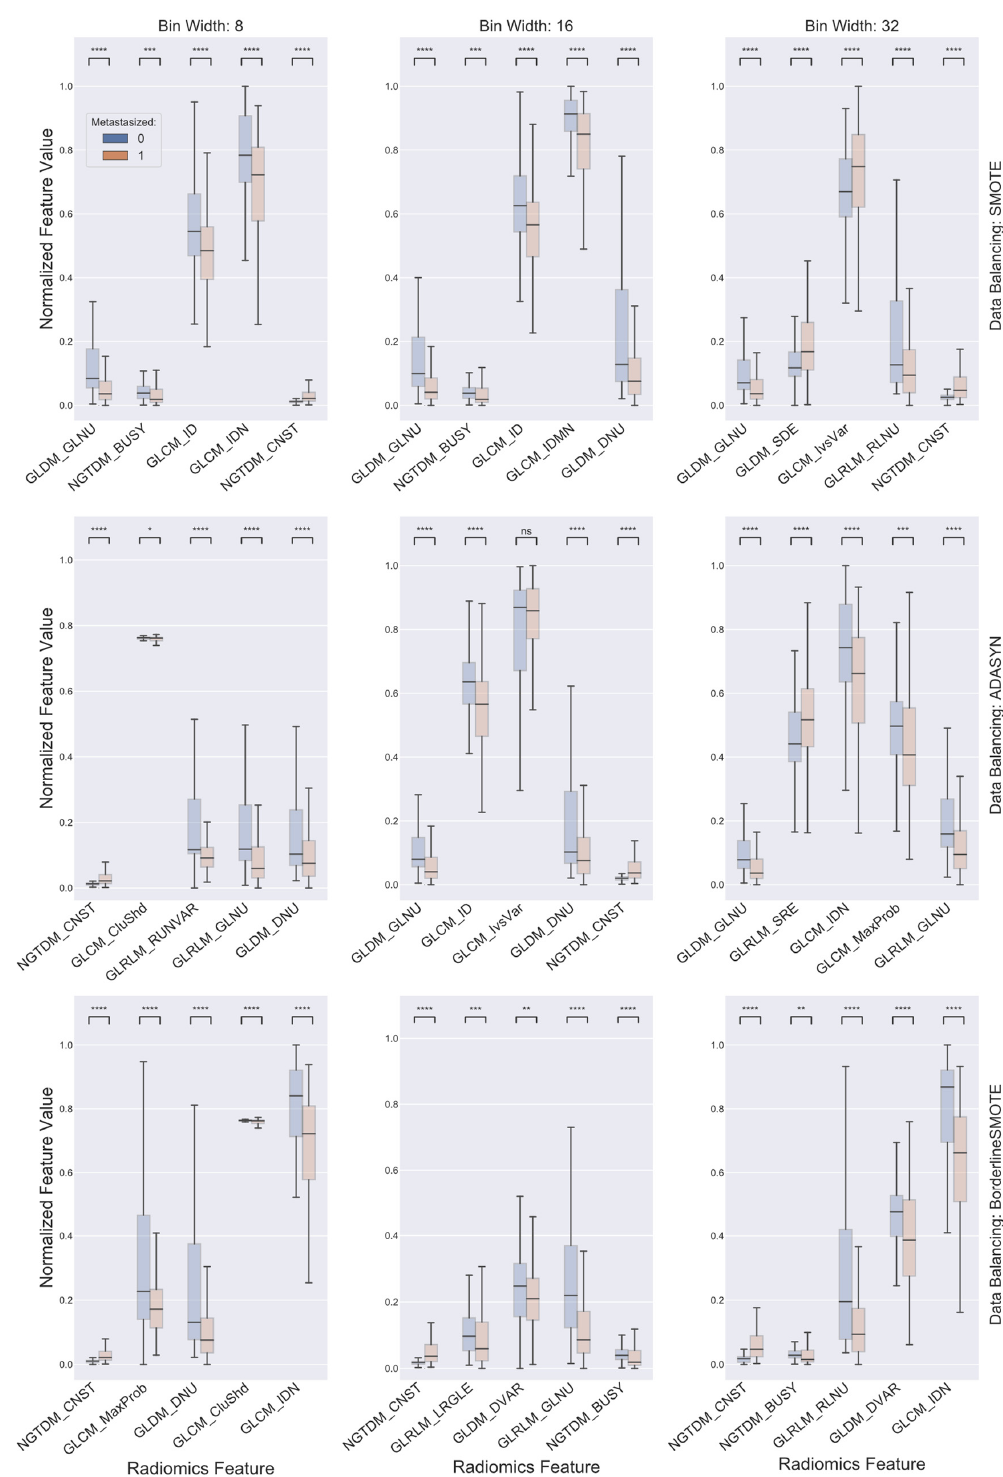
Figure 2. Boxplots comparing the top five radiomics features selected for each combination of gray level discretization schemes and data balancing algorithms between cohorts with (in red) and without (in blue) distant metastasis. The radiomics feature values were normalized to between 0 and 1 for visual display. On each box, the central mark indicates the median, and the top and bottom edges of the box indicate the 25th and 75th percentiles, respectively. For each box pair comparison: NS, not significant at level of 0.005; *, p < 0.005; **, p < 0.001; ***, p < 0.0001; and ****, p < 0.00001. All p values were corrected for multiple testing by the Bonferroni–Holm method.